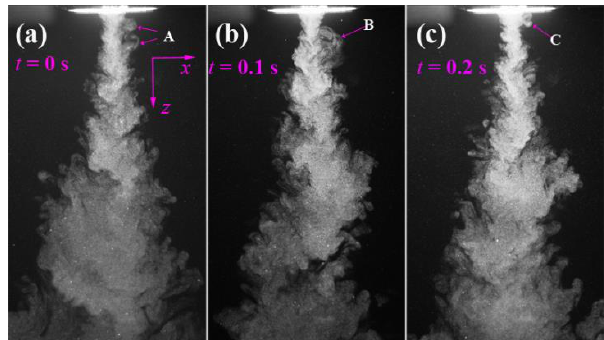
Figure 5. The visualized airflows in the “ x-z plane ( y = 15)” at different time instants of ( a ) t = 0 s, ( b ) t = 0.1 s, and ( c ) t = 0.2 s. The real size for each sub-image is 141.8 mm × 82.3 mm.